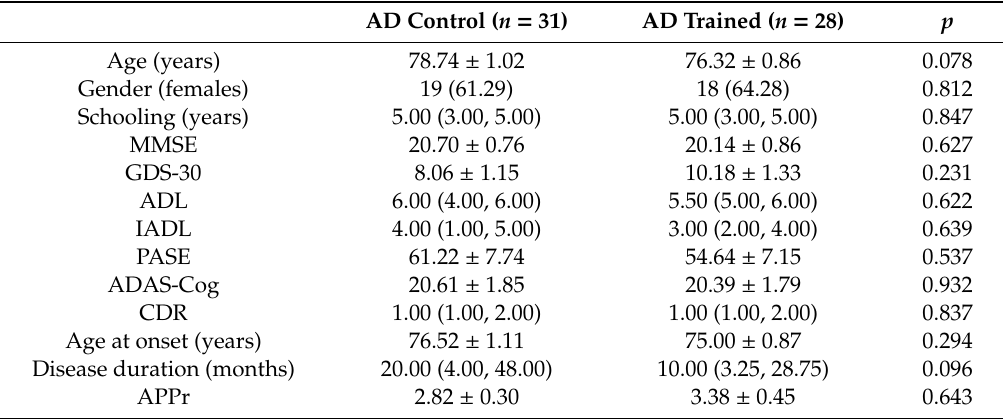
Table 1. Characteristics of the study population divided by